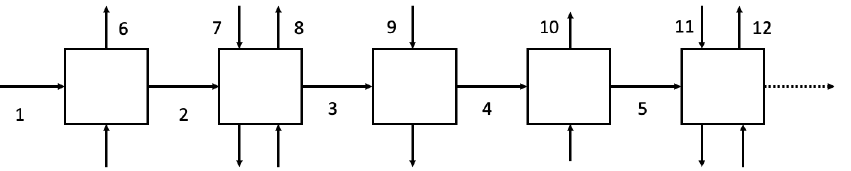
Figure 3. Representation of a signalized traffic network consisting of five intersections and twelve links.